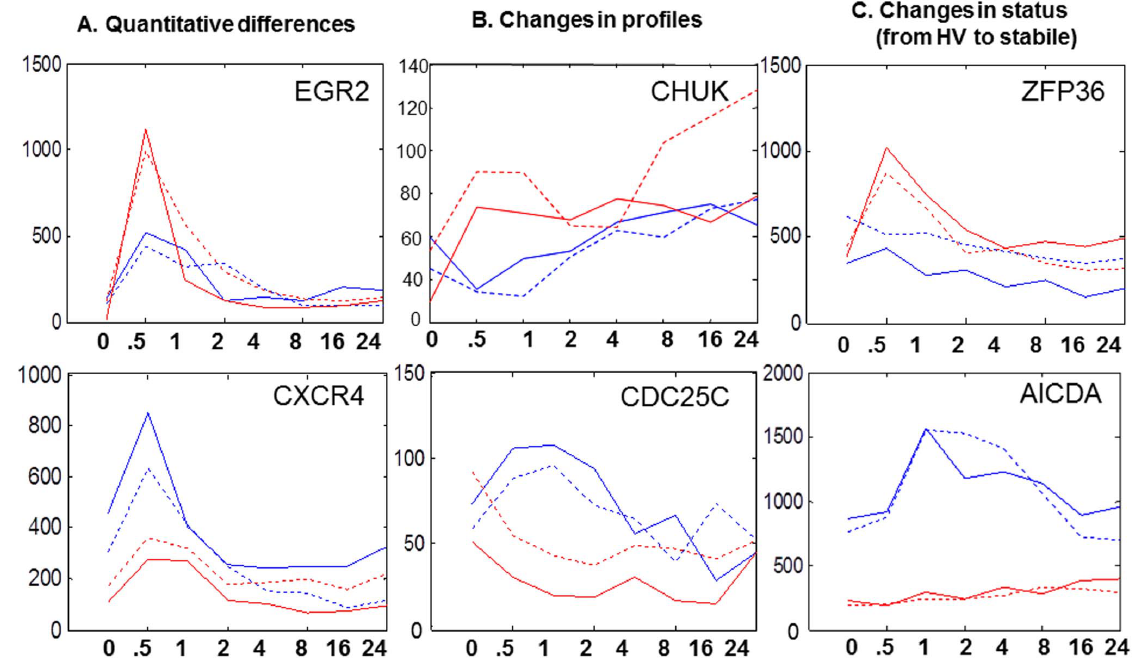
Figure 5. Differences in gene dynamics between normal control SLE samples. The shown profiles are representative of gene dynamics observed in duplicated experiments. Three differences in gene dynamics are shown: quantitative differences (left), changes in gene profiles (middle), and changes from hyper variable to stable (right). Graphs were shown as hours after stimulation (x-axis) and normalized gene expressions (y-axis). Each line on the graph represents one cell line. Each cell line was classified as a high responder (solid line) or low responder (hatched line). SLE patient sample gene expression is shown in red; while normal control sample gene expression is shown in blue.